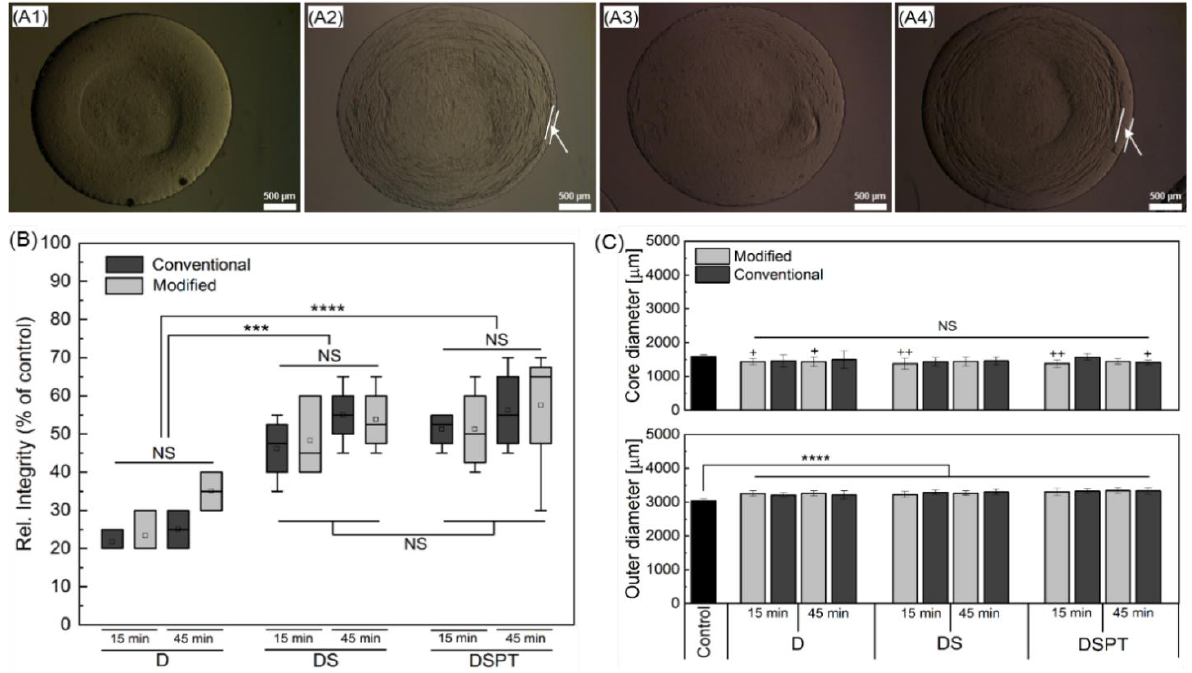
Figure 8. The effect of the cryopreservation on the integrity and size change of cell-free core-shell capsules after thawing. ( A ) Representative bright-field images of core-shell capsules before ( A1 ) and after freezing under protection of 10% DMSO (( A2 ), D), 10% DMSO and 0.3 M sucrose without (( A3 ), DS) and with capsule pretreatment with 0.1 M sucrose 24 h before freezing (( A4 ), DSPT) using the modified “in air” approach. White arrows on ( A2 , A4 ) indicate a possible effect of the CPA type on the preservation of the membrane integrity. Scale bars are 500 µm. ( B ) Relative capsule integrity according to the gradation of damage as detailed in Section 4.4.1. Kruskal–Wallis-test followed by post hoc Dunn’s multiple comparison ( p < 0.05): boxes show 25–75% data range, line and open quadrat markers in the box—median and mean, respectively, and whiskers—1.5IQR; NS—not significant, *** p < 0.001, **** p < 0.0001 ( n ≥ 3). Statistics indicates significant improvements in the relative capsule integrity after cryopreservation using 0.3 M sucrose to 10% DMSO as compared to 10% DMSO alone. ( C ) The effect of cryopreservation on the outer and core diameter after thawing as compared to core-shell capsules before freezing (control). One-way ANOVA ( p = 0.05) (normal distribution) with a Tukey’s post-hoc multiple comparison test. The data are presented as mean and standard deviation. In ( C ): **** the data are significantly different ( p < 0.0001) compared to the control, + and ++ define that the data are significantly different ( p < 0.05, p < 0.01, respectively) as compared to the control ( n ≥ 12).